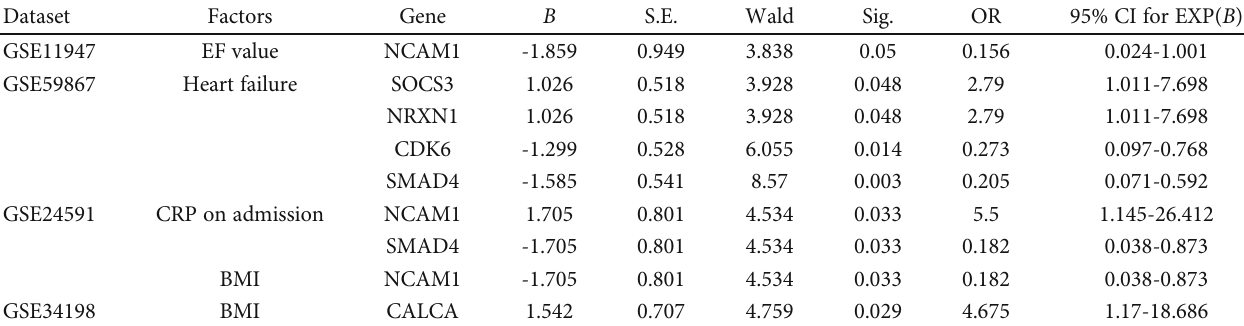
Table 4: The logistic regression of key gene expressions and clinical and prognosis factors in MI.